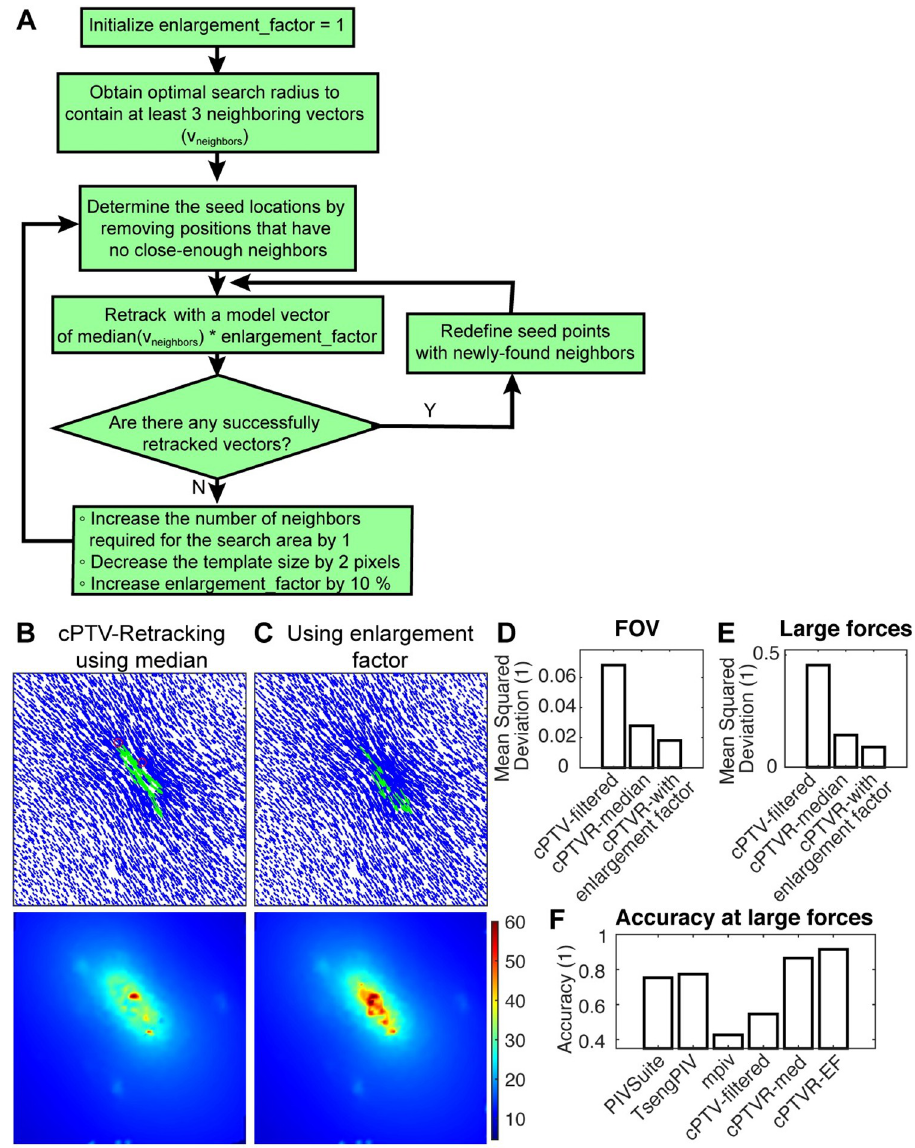
Fig 4. Containing the enlargement factor increases the possibility of identification of the large displacement vectors and the accuracy of the tracking. (A) A flowchart of an algorithm that adaptively retrack displacement vectors using the enlargement factor. See the main text for the details. (B,C) Final displacement fields (top) and associated displacement maps (bottom) resulted from cPTVR with a median vector as a model vector (B) and with a progressive enlargement in the model vector (C). Green arrows represent vector outliers determined by ones showing more than 10% MSD. (B) was converged in 317 iterations whereas (C) converged in 119 iterations. (D,E) Bar plots of MSD for the measured displacement fields in the entire field of view (D) or in the large force area defined in Fig 1C (E). Note that cPTVR with enlargement factor has much smaller MSD than the filtered cPTV or cPTVR with a median model vector. (F) A bar plot of the accuracy at the large force area between three PIV methods and three cPTV